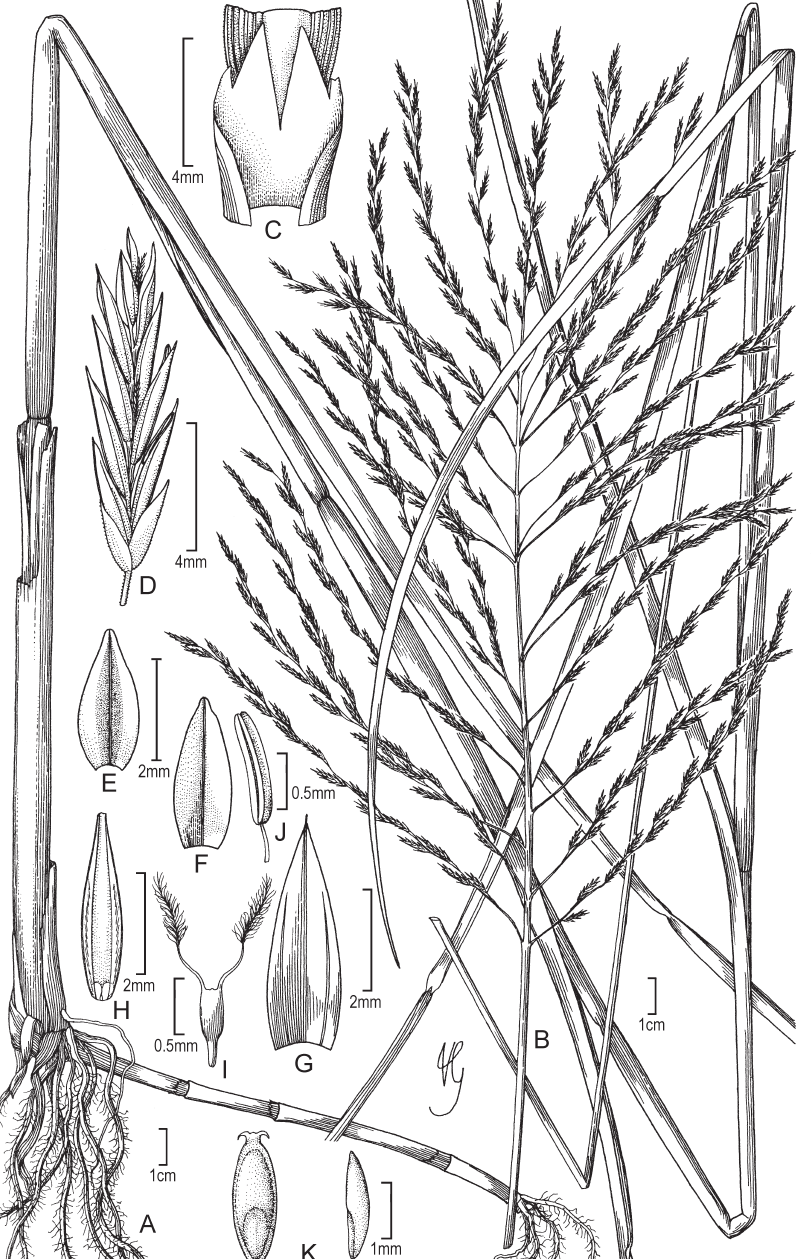
Figure 9. A–K Diplachne gigantea Launert A habit B inflorescence C ligule D spikelet E lower glume F upper glume G lemma H palea and lodicules I ovary and stigmas J stamen K caryopsis, dorsal view (left) and lateral view (right). Drawings from McCallum Webster A305 (K), from